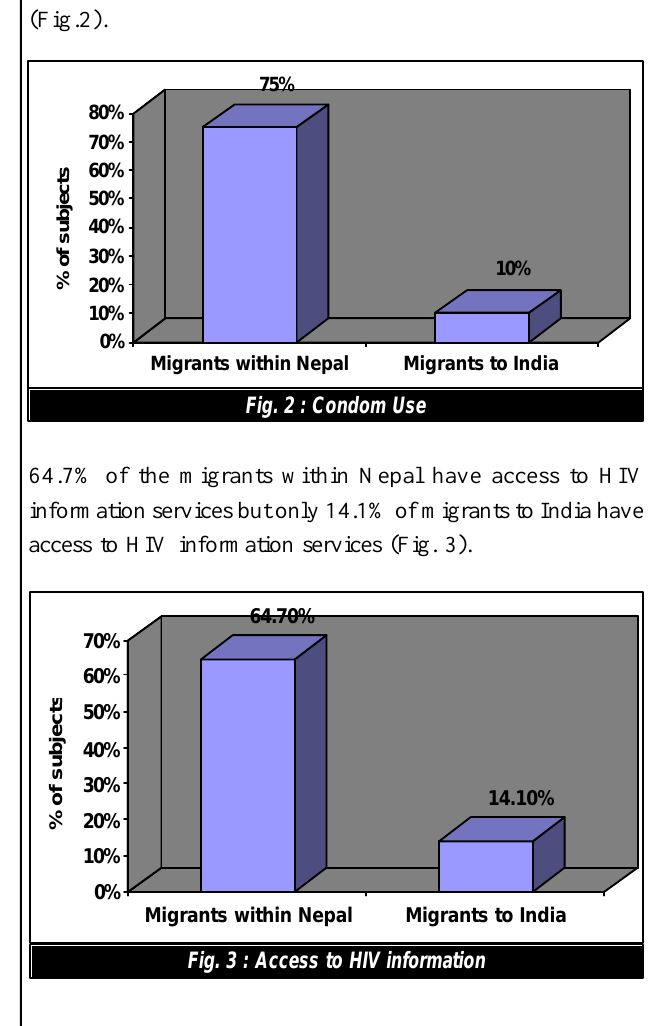
Fig. 3 : Access to HIV information